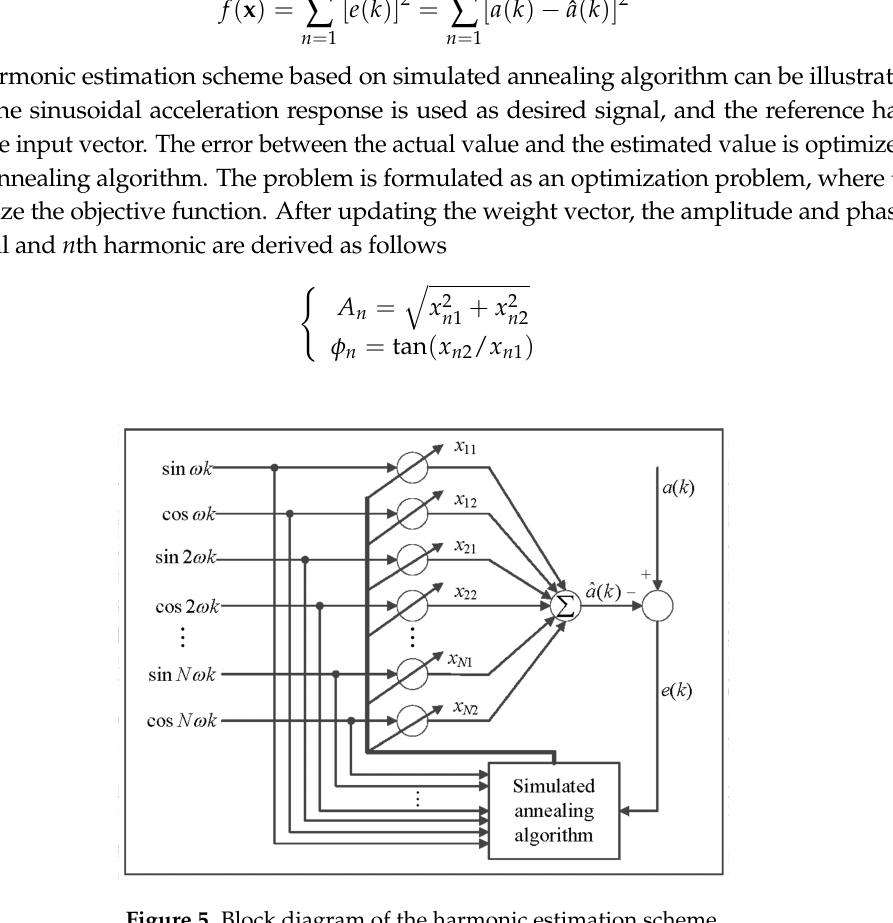
Figure 5. Block diagram of the harmonic estimation